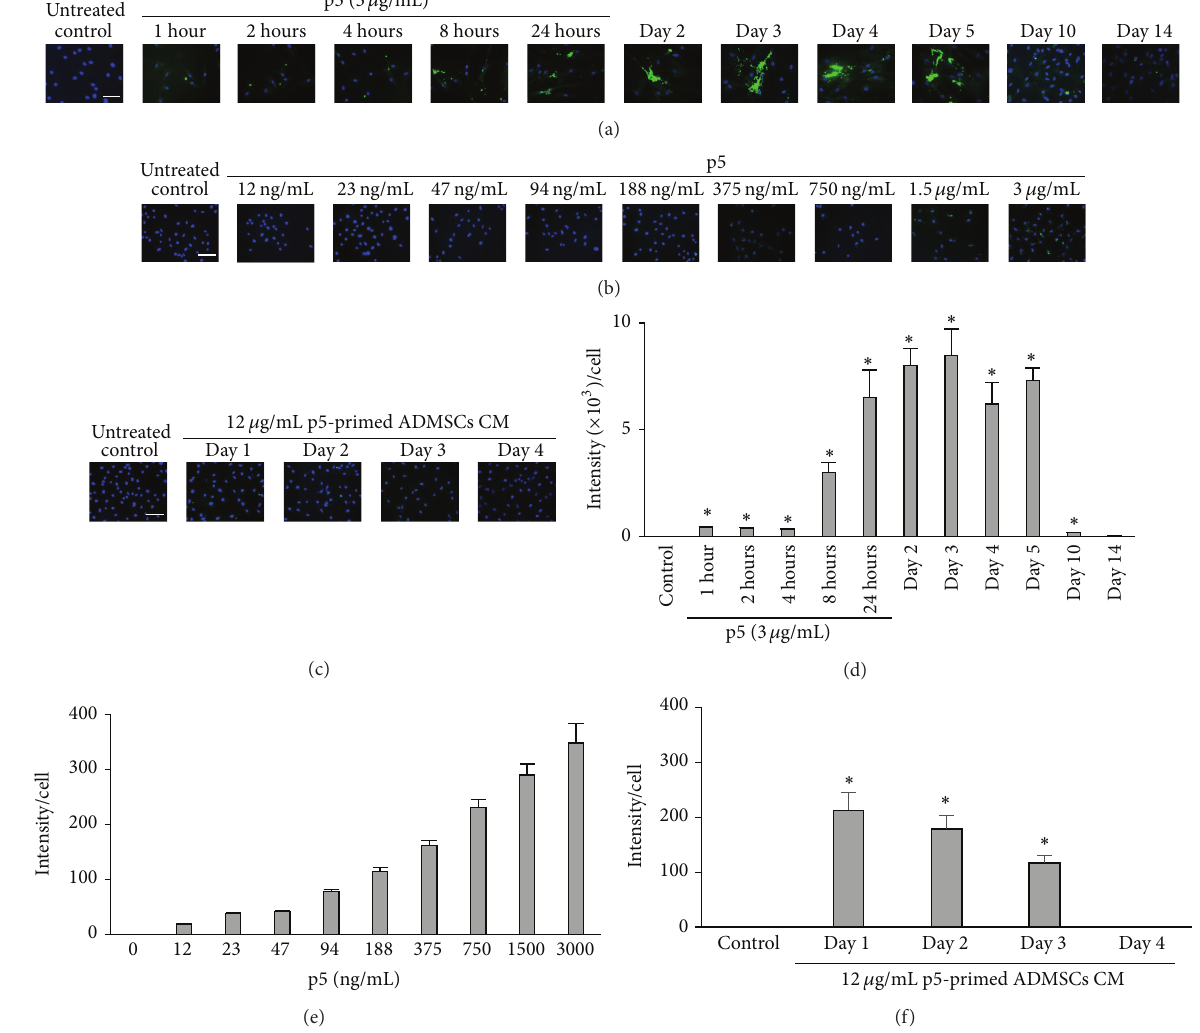
Figure 1: The p5 internalization and release by hADMSCs. (a) The internalization of p5 was analyzed by fluorescence microscopy in hADMSCs primed 1, 2, 4, 8, or 24 hours with 3 𝜇 g/mL p5 (green). Cells were also observed after 24 hours priming on Days 2, 3, 4, 5, 10, and 14. (b) The internalization of p5 was analyzed by fluorescence microscopy in BAECs primed with different doses of p5 (green) for 24 hours. The intensity of p5 staining in cytoplasm was correlated with the dosages of p5. (c) Subconfluent cultures (2 × 10 5 ) of adherent hADMSCs were exposed to 12 𝜇 g/mL biotinylated p5 for 24 hours. After several washes and trypsinization, p5-primed hADMSCs were further cultured and their conditioned medium (CM) was collected every 24 hours. The internalization of p5 was analyzed by fluorescence microscopy in BAECs treated with p5-primed hADMSCs CM for 24 hours. Scale bar: 100 𝜇 m. (d) The fluorescein staining intensities of p5 in hADMSCs in (a) were quantified in the bar graph as means ± SD (error bars). Significance (denoted as ∗ ) was calculated compared to the untreated control group using Student’s 𝑡 -test (with 𝑝 < 0.01 , 𝑛 = 6 ). (e) The fluorescein staining intensities of p5 in BAECs in (b) were quantified in the bar graph as means ± SD (error bars). (f) The fluorescein staining intensities of p5 in BAECs in (c) were quantified in the bar graph as means ± SD (error bars). Significance (denoted as ∗ ) was calculated compared to the untreated control group using Student’s 𝑡 -test (with 𝑝 < 0.01 , 𝑛 = 6